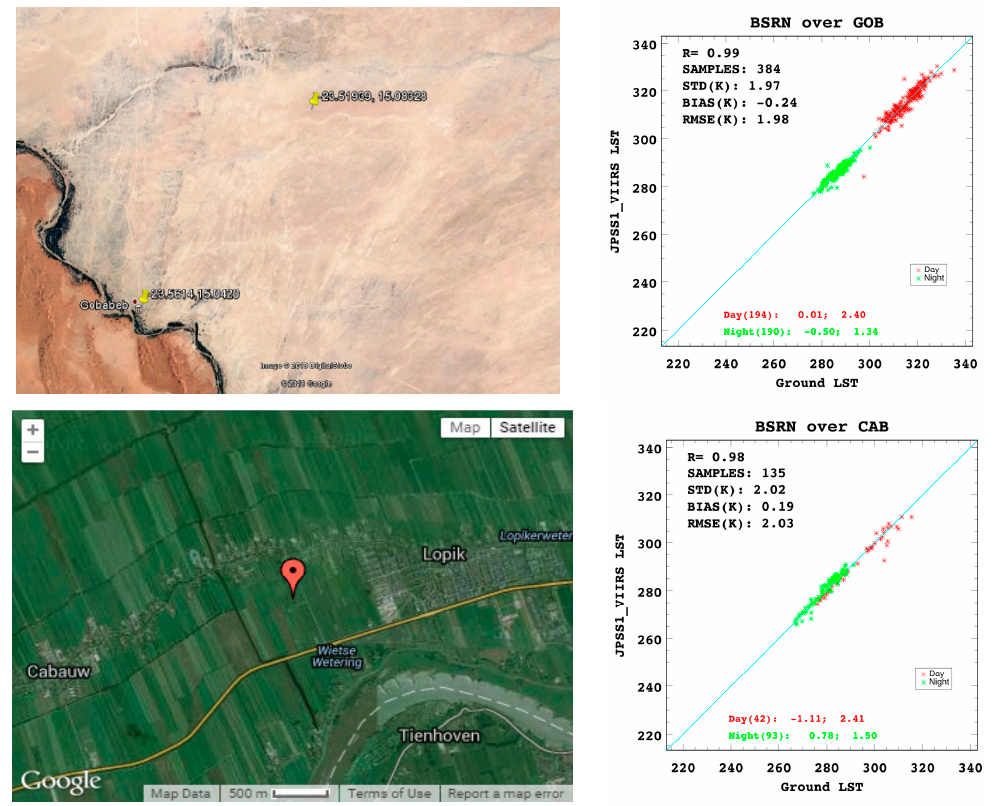
Figure 7. Baseline Surface Radiation Network (BSRN) site map and validation result: GOB site (top) and Cabauw, The Netherlands (CAB) site (bottom).